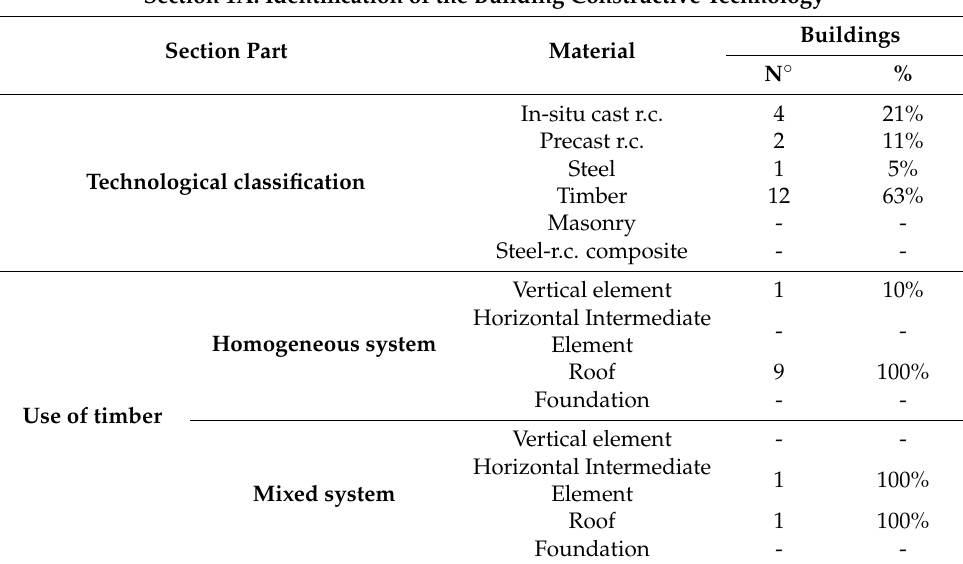
Table 3. Section 1A CARTIS-Building. Case studies characterization: Identification of the building constructive technology—Synoptic